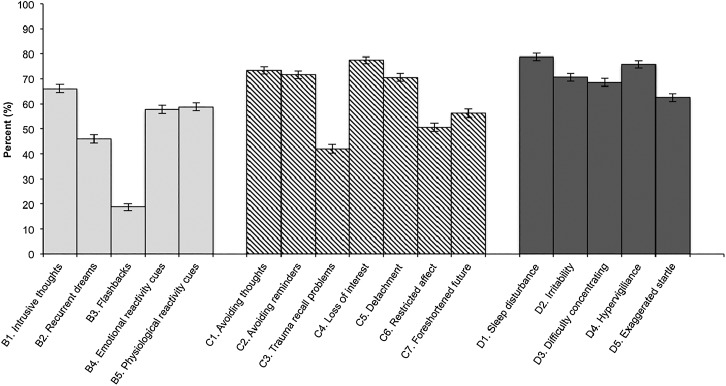
Distribution of Diagnostic and Statistical Manual of Mental Disorders, 4th edition
(DSM-IV) post-traumatic stress disorder (PTSD) criteria B (intrusive recollection),
C (avoidance/numbing) and D (hyperarousal) symptoms among responders with active
World Trade Center PTSD in 2012–2014. Values are percentages, with 95% confidence
intervals represented by vertical bars.